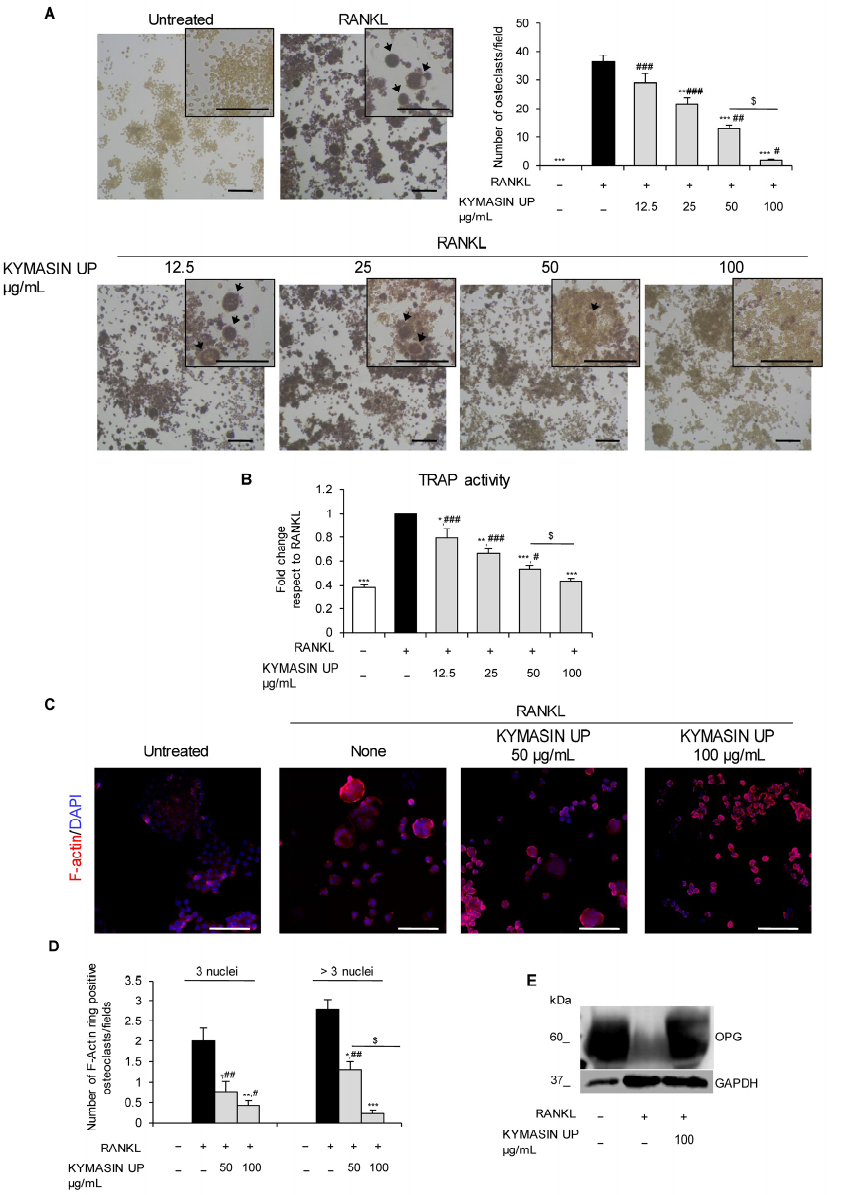
Figure 2. ( A – E ) RAW 264.7 cells were treated for 5 days with RANKL in the absence (black bars) or presence of KYMASIN UP (12.5–100 µg/mL) (grey bars). The untreated control was also shown (white bars). ( A ) TRAP (tartrate-resistant acid phosphatase) staining was performed and TRAP- positive OCs ( ≥ 3 nuclei) were counted. Representative images and high-magnification insets are reported (arrows mark OCs). ( B ) The supernatants of cells in A were collected, and TRAP activity was measured by ELISA and reported as fold change vs. RANKL treatment (black bar). ( C ) The F- actin ring (red) formation in RANKL-induced OCs was assessed using phalloidin fluorescence